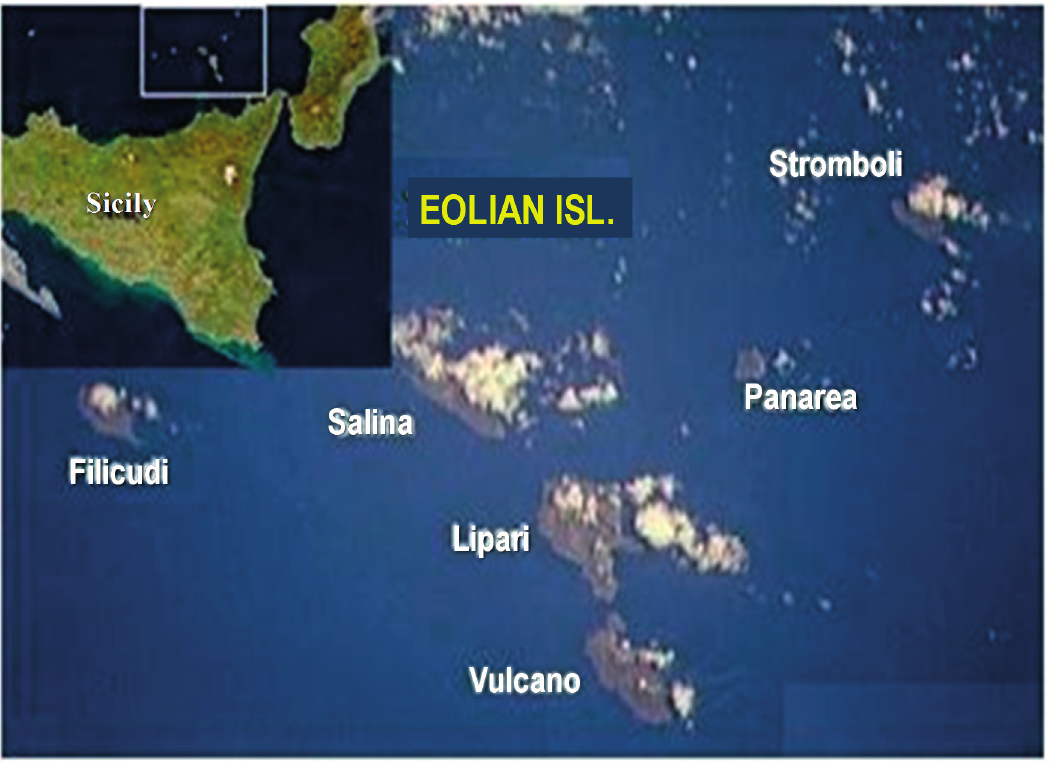
Figure 1. Eolian Archipelago (Italy).